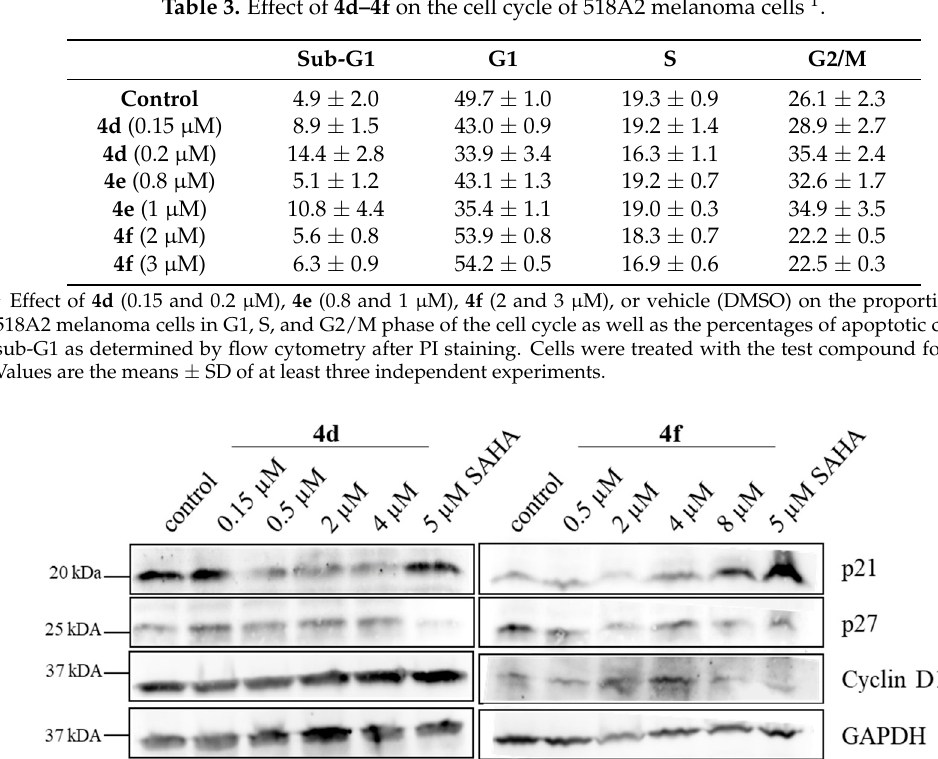
Figure 7. Compound-induced effects on cell cycle regulatory proteins in 518A2 melanoma cells after 24 h treatment with 4d , 4f , and SAHA. GAPDH served as a loading control. Representative data of three independent experiments are shown.